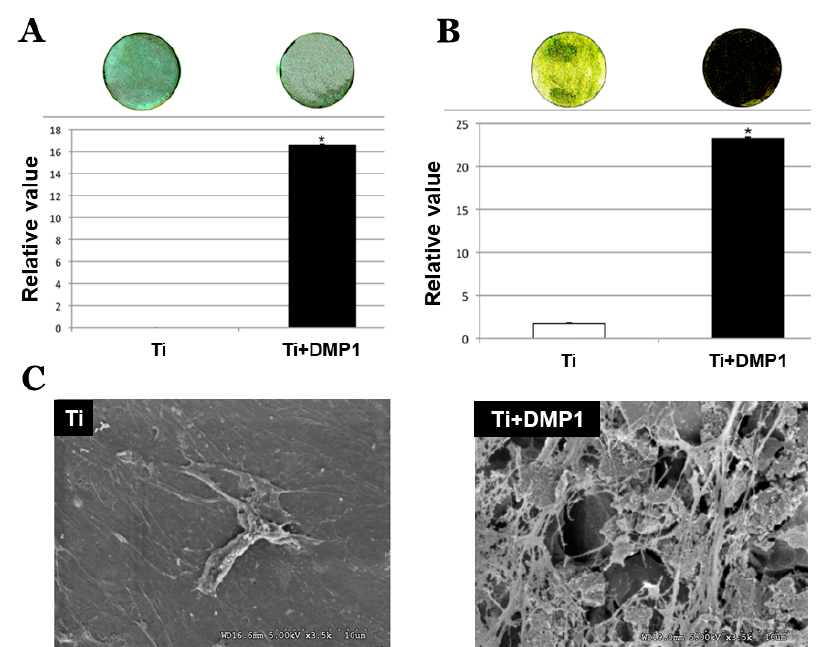
Figure 5. Images of alkaline phosphatase activity and bar graphs represent the means ± SD of triplicate experiments of Ti disk and Ti disk+DMP 1 ( A ). Images of von Kossa staining and bar graph represent the means ± SD of triplicate experiments of Ti disk and Ti disk+DMP 1 ( B ). SEM images of the cellular extracellular matrix on Ti ( C ) and Ti disk + DMP1.